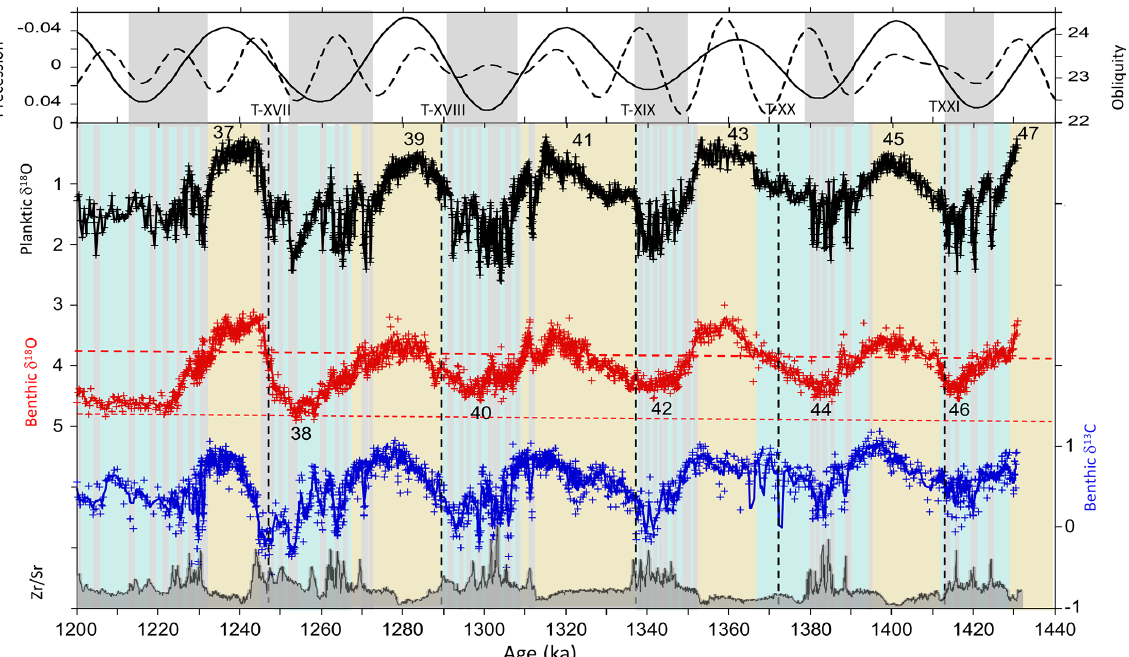
Figure 12. Same as Fig. 6 but for 1200–1440ka, when glacial–interglacial cycles were occurring every 41kyr. Note the increase in MCV associated with obliquity